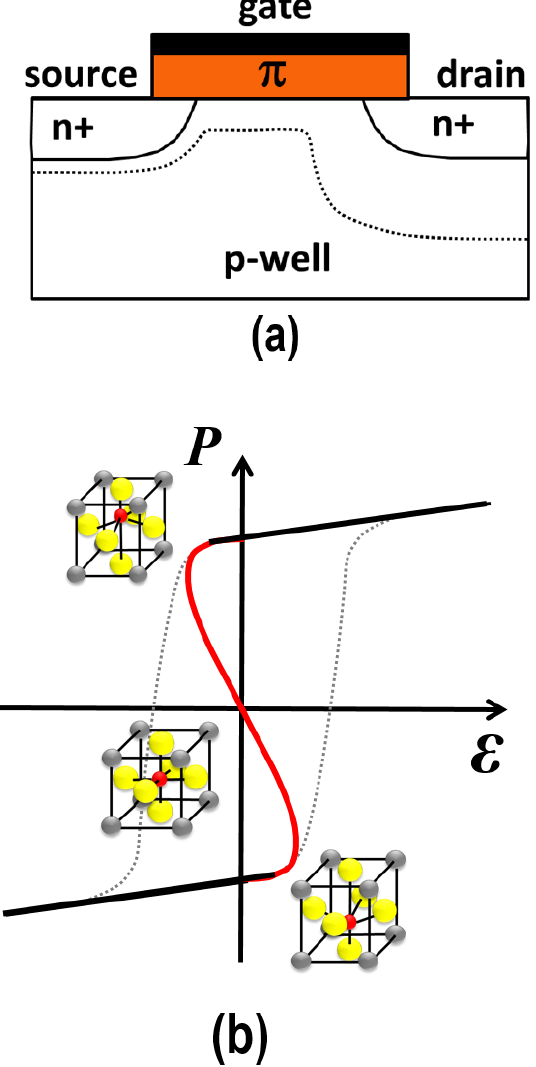
Figure 3. ( a ) schematic cross-section of the originally proposed NC-FET; ( b ) the “S”-shaped P - E curve highlighting the negative slope ∂ P / ∂ E hence negative capacitance. The NC-FET operation is inside the P - E